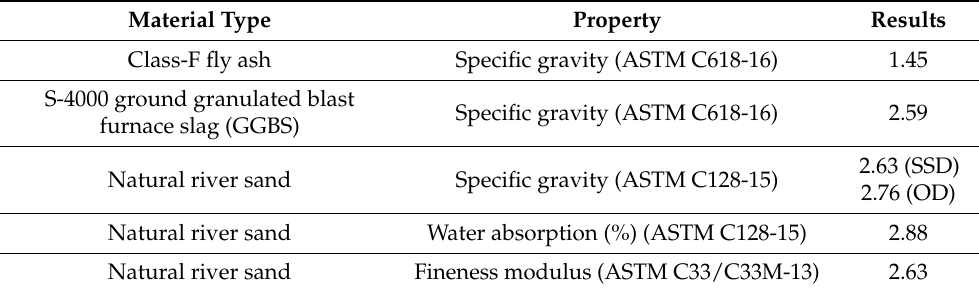
Figure 4. Sieve analysis of natural river sand.